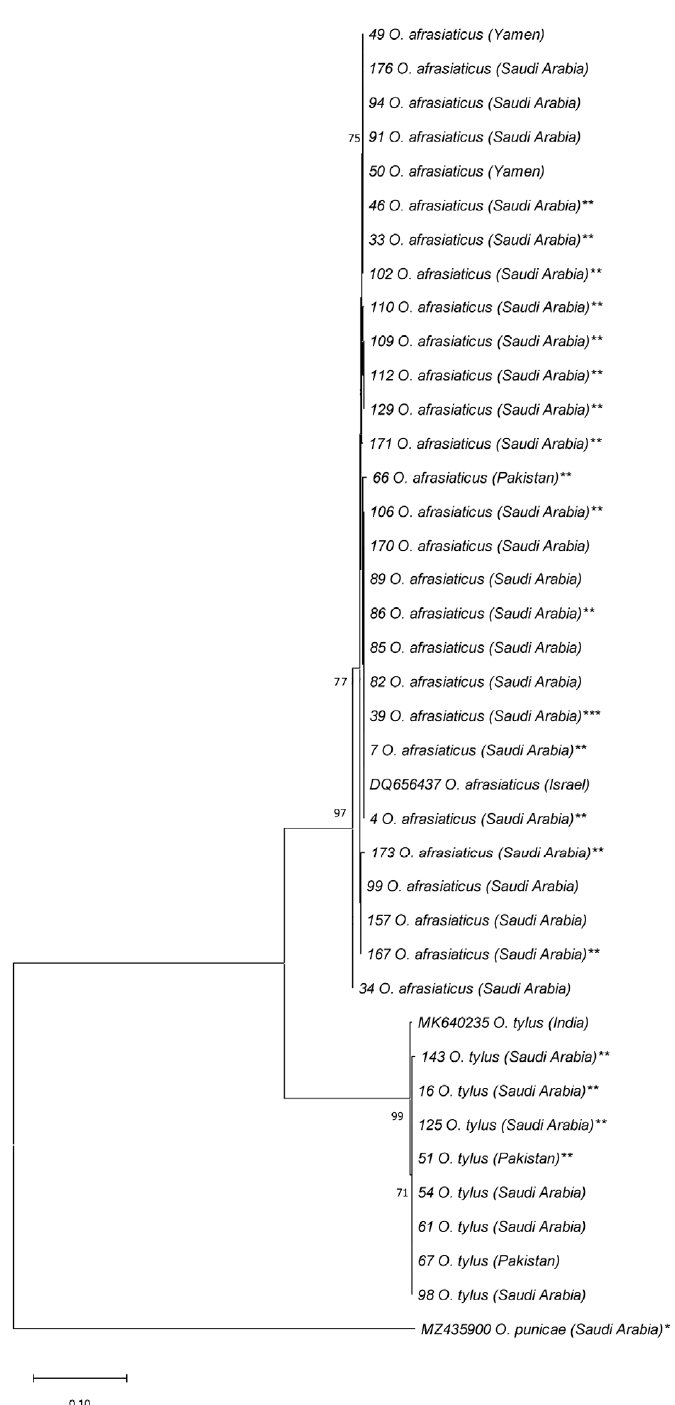
Figure 5. NJ tree based on 39 ITS2 sequences, representing different populations of the two closely related Oligonychus species ( O. afrasiaticus and O. tylus ) and one distantly related species, O. punicae (* was retrieved from GenBank and used as an outgroup taxon). A total of 31 sequences were obtained in the present study from different hosts and regions in Saudi Arabia, three from Pakistan, and two from Yemen. In total, 19 samples ** have not been morphologically identified till species level due to the absence of males, and *** one sample previously claimed as O. pratensis from Saudi Arabia [23]. The sequences of O. afrasiaticus from Israel and O. tylus from India were retrieved from GenBank. Numbers on tree branches are bootstrap values obtained from 1000 replicates.